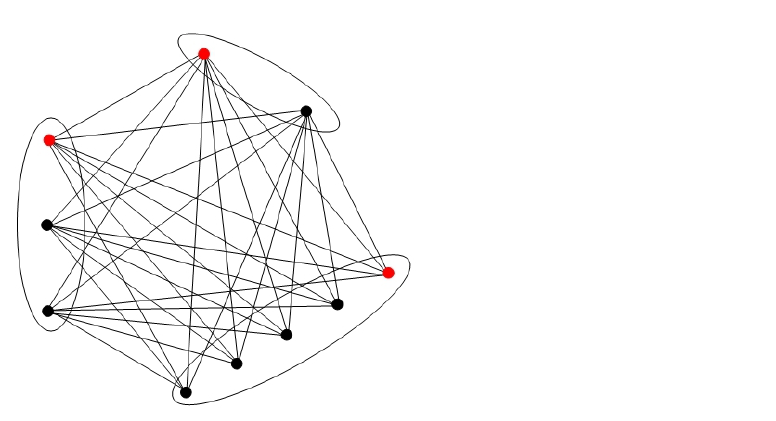
Figure 3. The complete multipartite graph K 2,3,5 with a metric generator (black